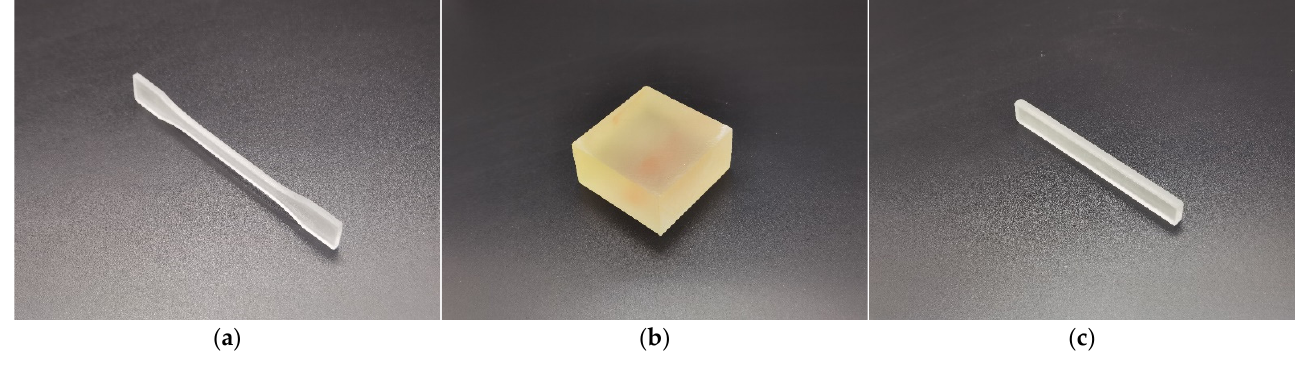
Figure 3. Actual photograph of the fabricated samples. ( a ) For the detection of tensile strength; ( b ) for the detection of compressive strength; ( c ) for the detection of flexural modulus.